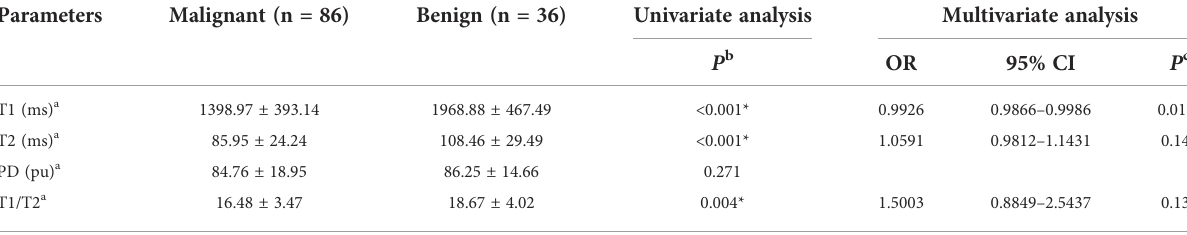
TABLE 2 Comparison of quantitative T1/T2/PD Measures between Benign and Malignant Groups.